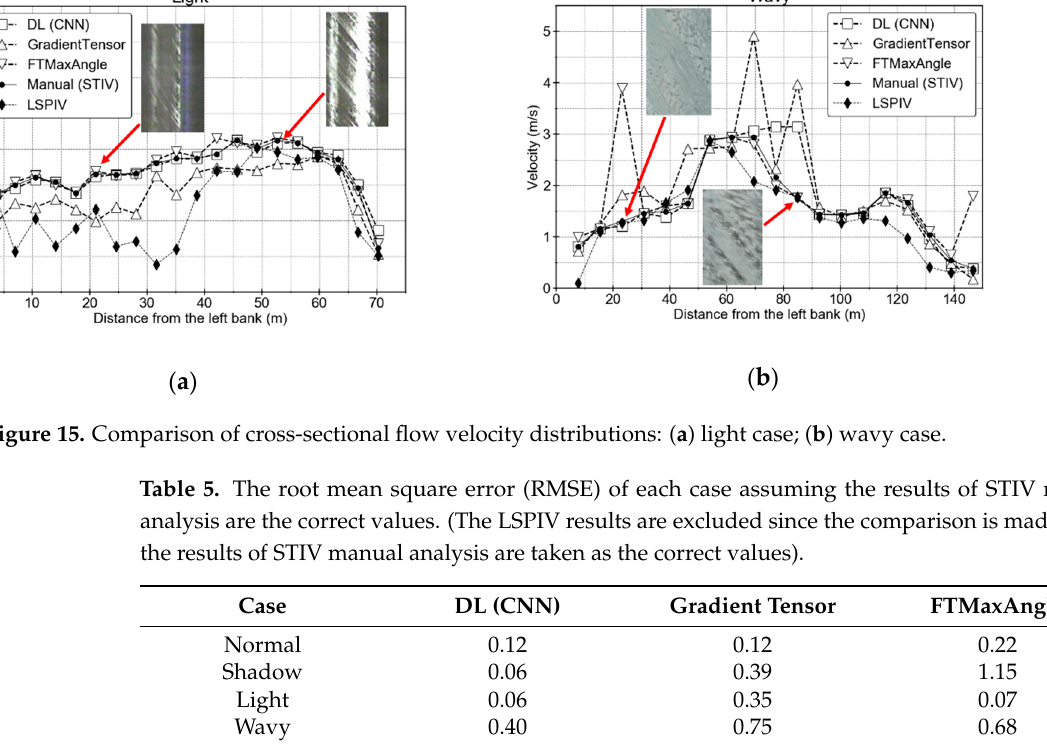
Figure 14. Comparison of cross-sectional flow velocity distributions: ( a ) normal case; ( b ) shadow case (STIs on the graph are histogram equalization filtered for visibility).